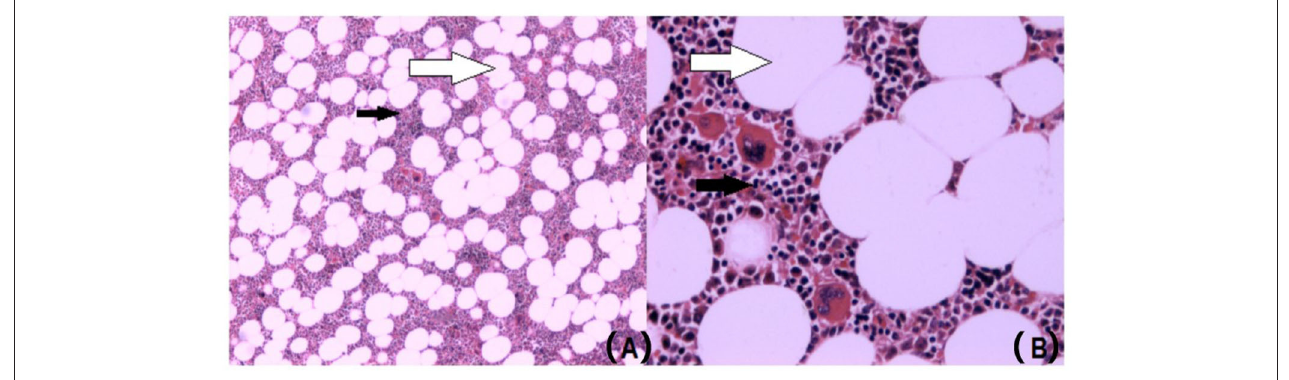
needed to take antihypertensive drugs and postoperative blood pressure were